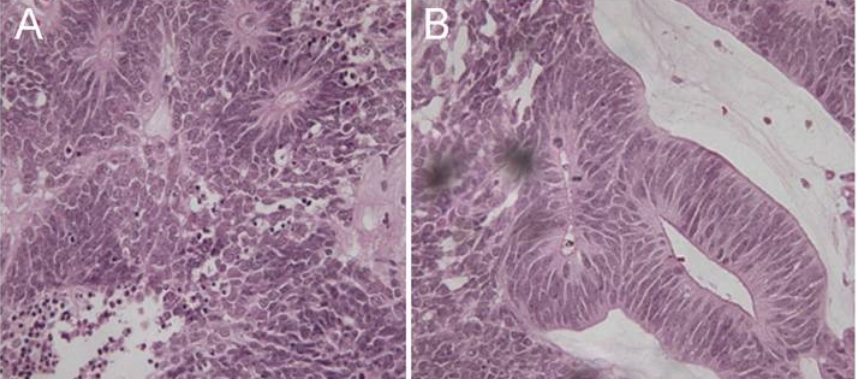
Figure 2: (A) H&E staining of tumor showing Flexner-Wintersteiner rosettes; many mitotic figures can be seen. (B) Cellular mass extends from ciliary epithelium with multilayered cords, tubules, and sheets resembling primitive medullary epithelium. to be locally aggressive toward neighboring intraocular structures, but it rarely metastasizes